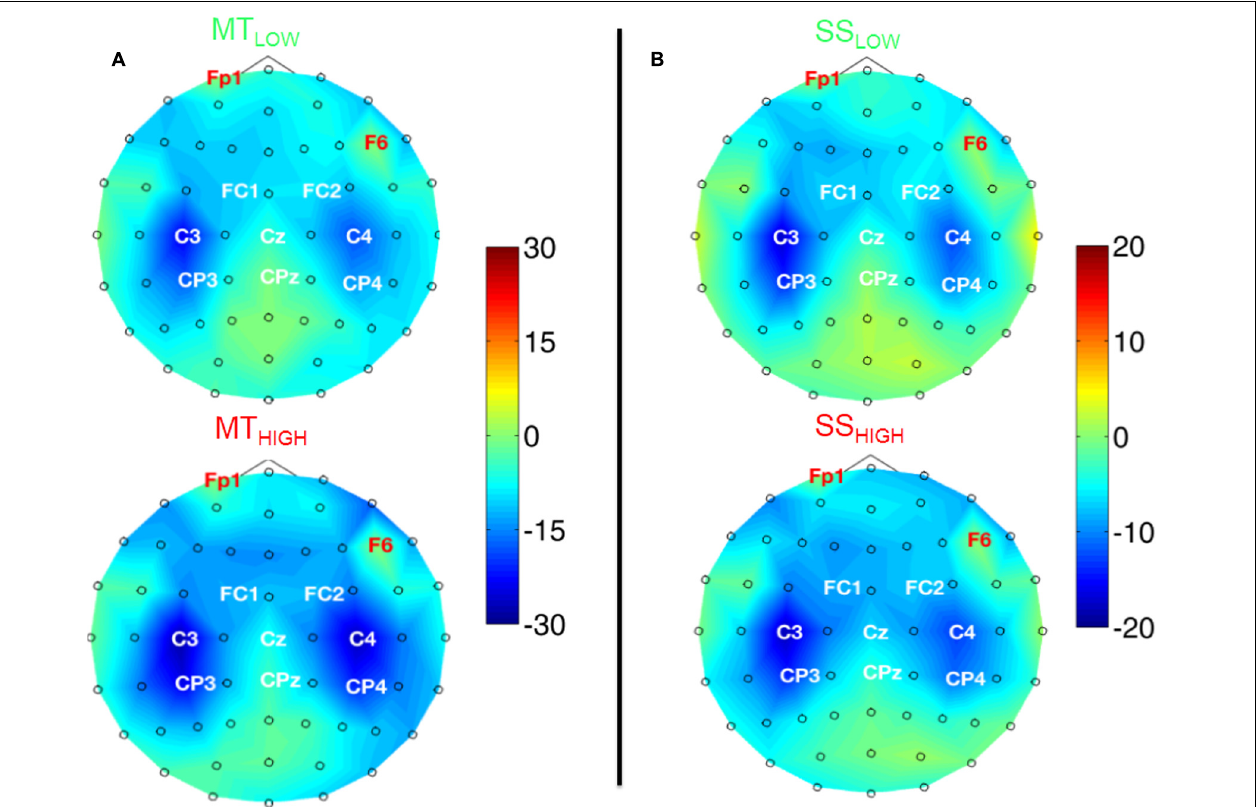
FIGURE 4 | Scalp maps depicting power changes in the alpha band during execution of the MT (subfigure A ) and sensory stimulation of the fingertips (SS; subfigure B ) relative to rest and averaged over all subjects. Event-related synchronization (ERS) is encoded in red and desynchronization (ERD) in blue. Channels denoted with red letters were removed from the analysis and set to neutral in the plots. All experimental conditions were characterized by highly similar spatial configurations covering bilateral sensorimotor areas with peak ERDs around the contralateral motor cortex (C3), ipsilateral motor cortex (C4), and the contralateral centro-parietal cortex (CP3). Execution of the MT lead to a significantly stronger ERD in these channels compared to sensory stimulation (note the scaling of the color bars). There were no significant differences within the ERDs caused by the MT with low and high intensity or SS with low and high intensity.